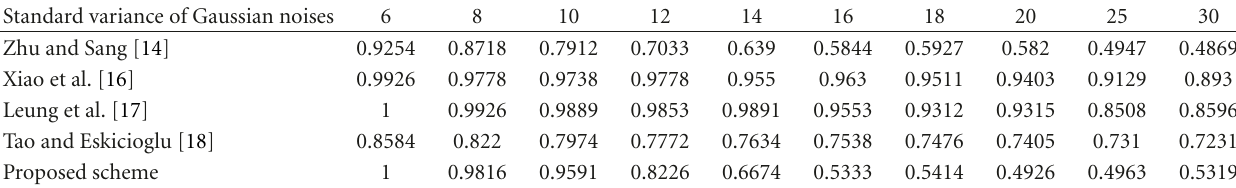
Table 2: Experiment results comparison under Gaussian noises (NC values).